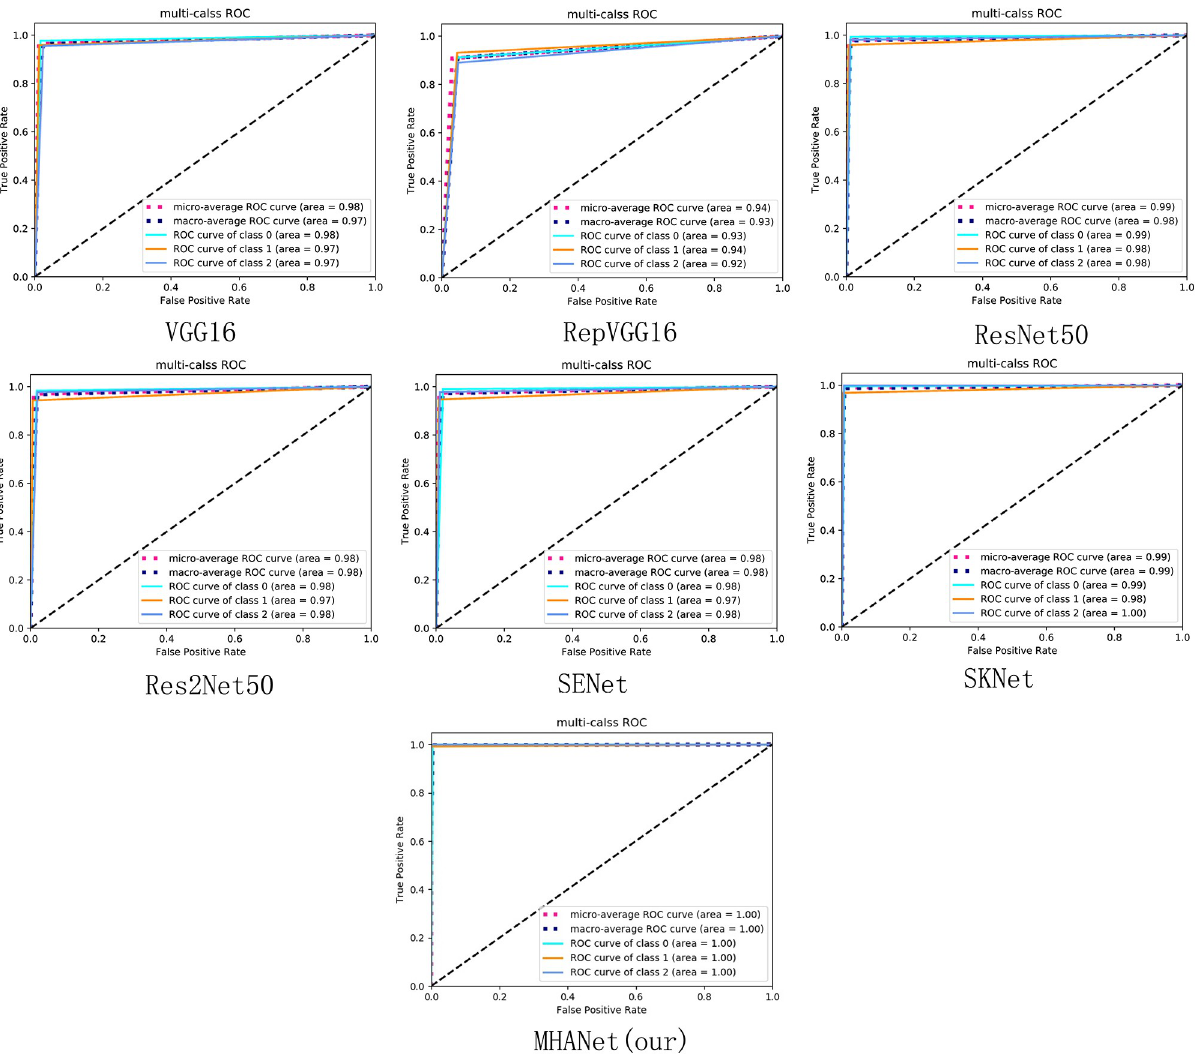
Fig 9. The micro-average ROC curve is obtained by the micro method in the sklearn.metrics.roc-auc-score function. The macro-average ROC curve is obtained by the macro method in the sklearn.metrics.roc-auc-score function. Class 0, class 1, and class 2 in the figure represent AMD, DME, and NORMAL,